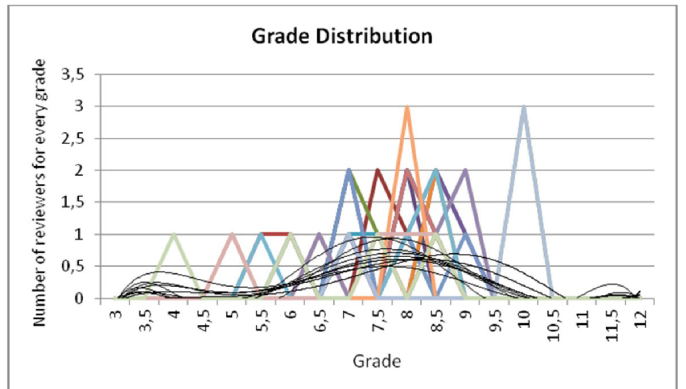
Figure 3. Distributon of the grades given to each explanaton, with a polynomial interpolaton curve of order 6 (the grades exceed 10 in the fgure to allow proper interpretaton of the interpolatng